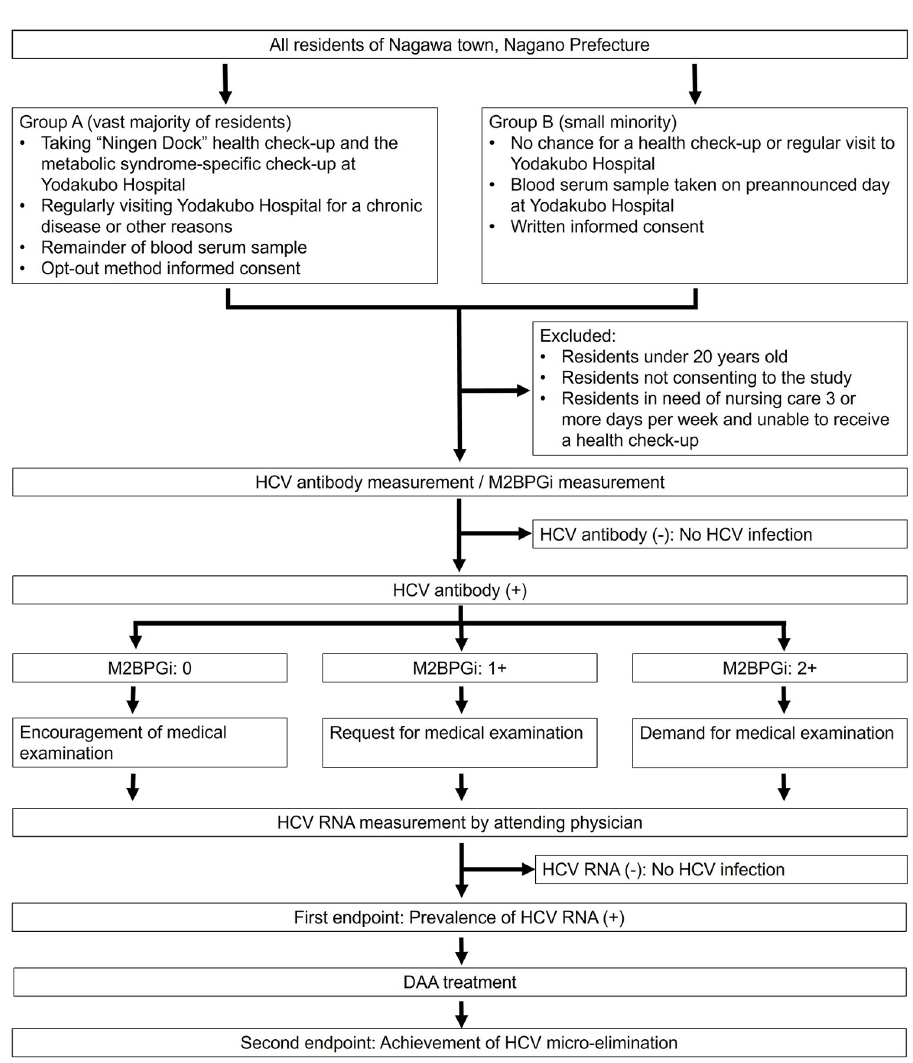
Fig 1. The study flowchart of the Nagawa Project. Abbreviations: HCV, hepatitis C virus; M2BPGi, MAC-2 binding protein glycosylation isomer.